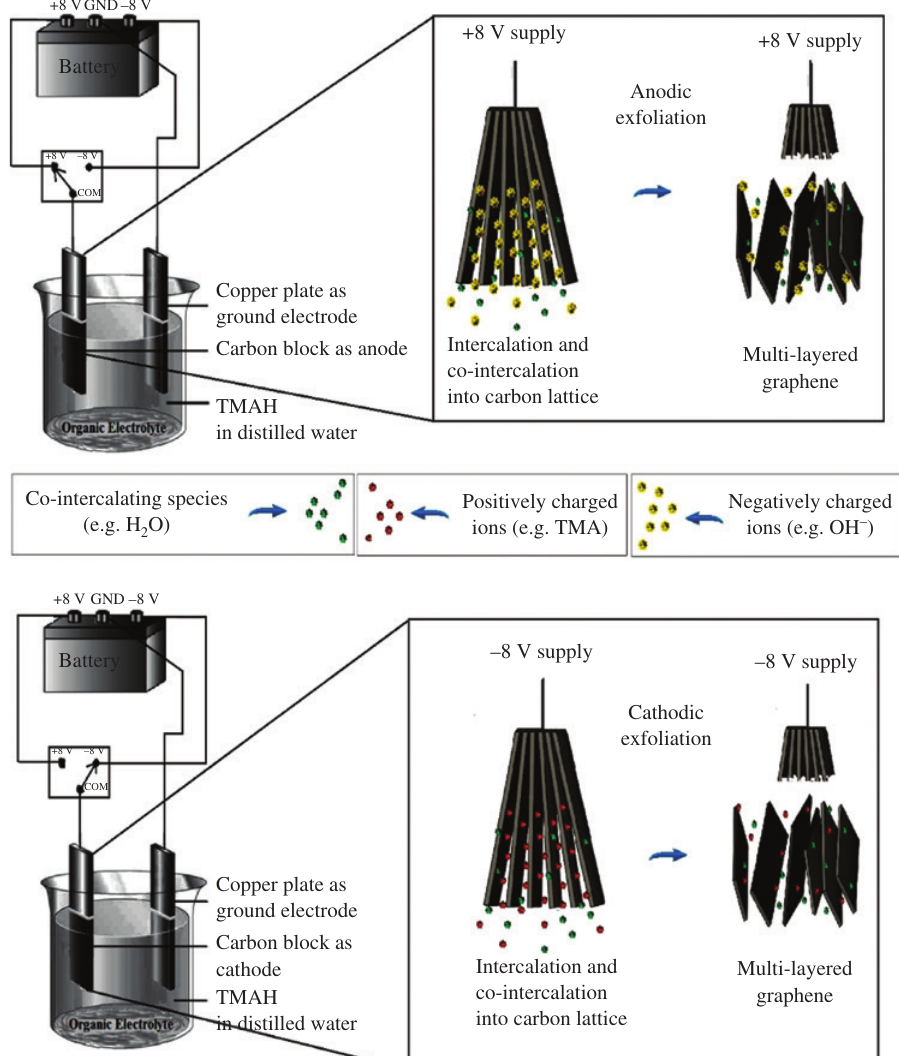
Figure 3: Schematic overview of anodic and cathodic exfoliation